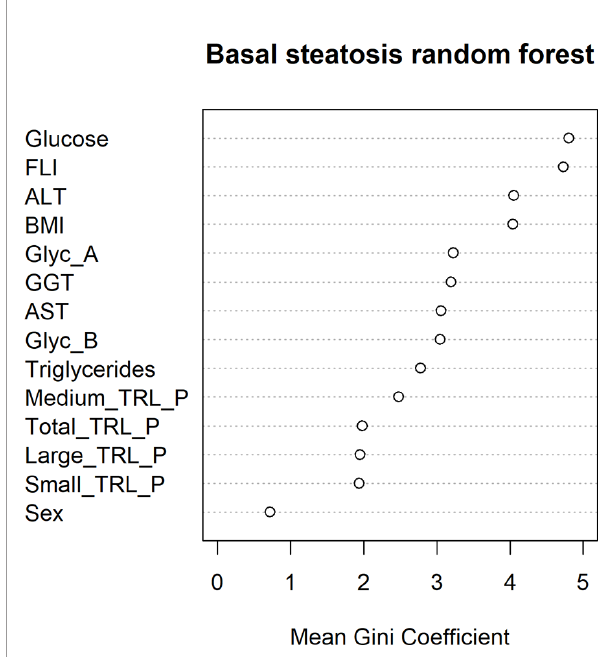
FIGURE 2 | Random forest mean Gini Coef fi cient for each variable in order to study their importance in the classi fi cation of ultrasound-con fi rmed hepatic